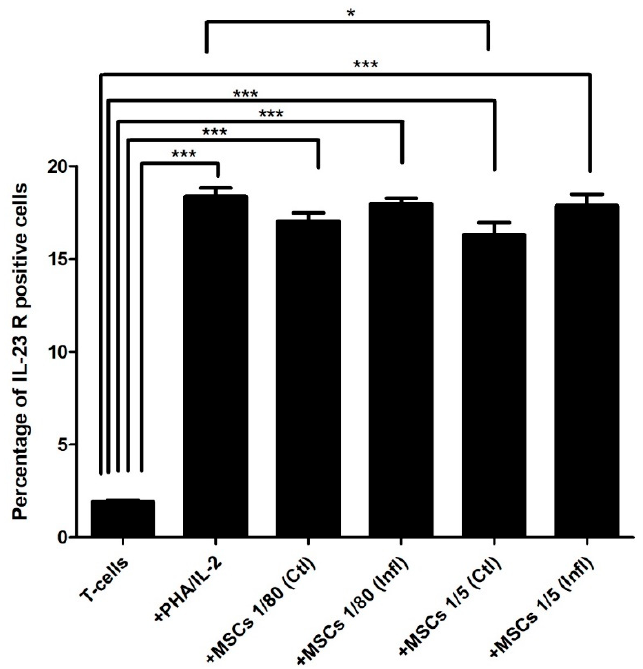
Figure 5. Influence of FSK-MSCs on IL-23 receptor expression. FSK-MSCs were cocultured at a (1:5) or (1:80) cell ratio under normal and inflammatory conditions with either unactivated or PHA/IL-2- activated T cells as indicated. Levels of IL-23 receptor expression were analyzed by flow cytometry. Data are expressed as the percentage of IL-23 receptor ± SEM-positive cells from seven independent experiments. * p < 0.05, *** p < 0.01 versus control.